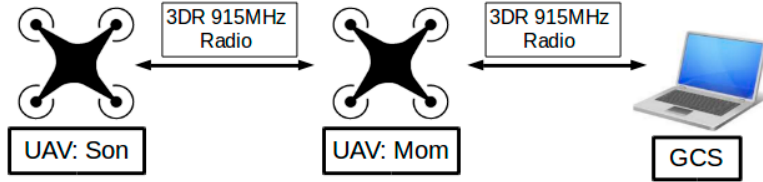
Figure 2. Whole architecture of the communication relay system.